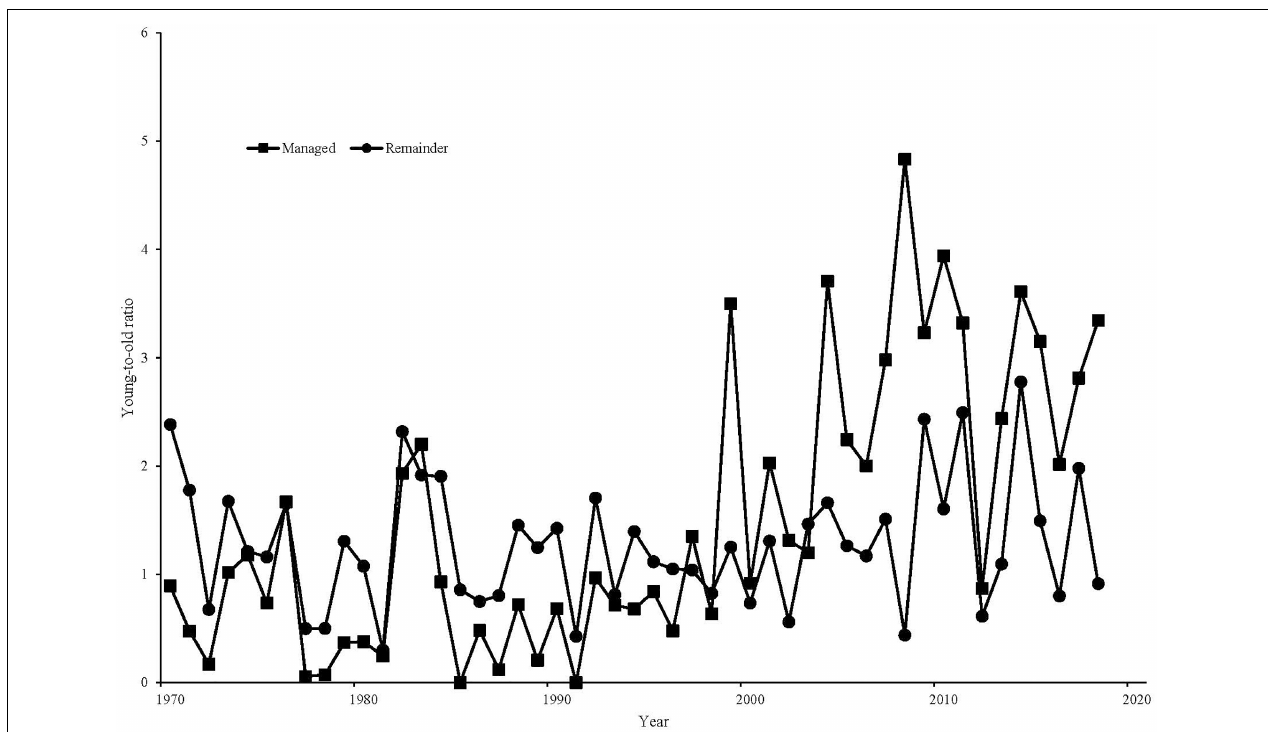
FIGURE 5 | Young-to-old ratios of gray partridges on the GWCT’s Sussex Study area, 1970–2018. Squares represent the land specifically managed for gray partridges from the mid-2000s. Circles represent land not subjected to partridge-specific